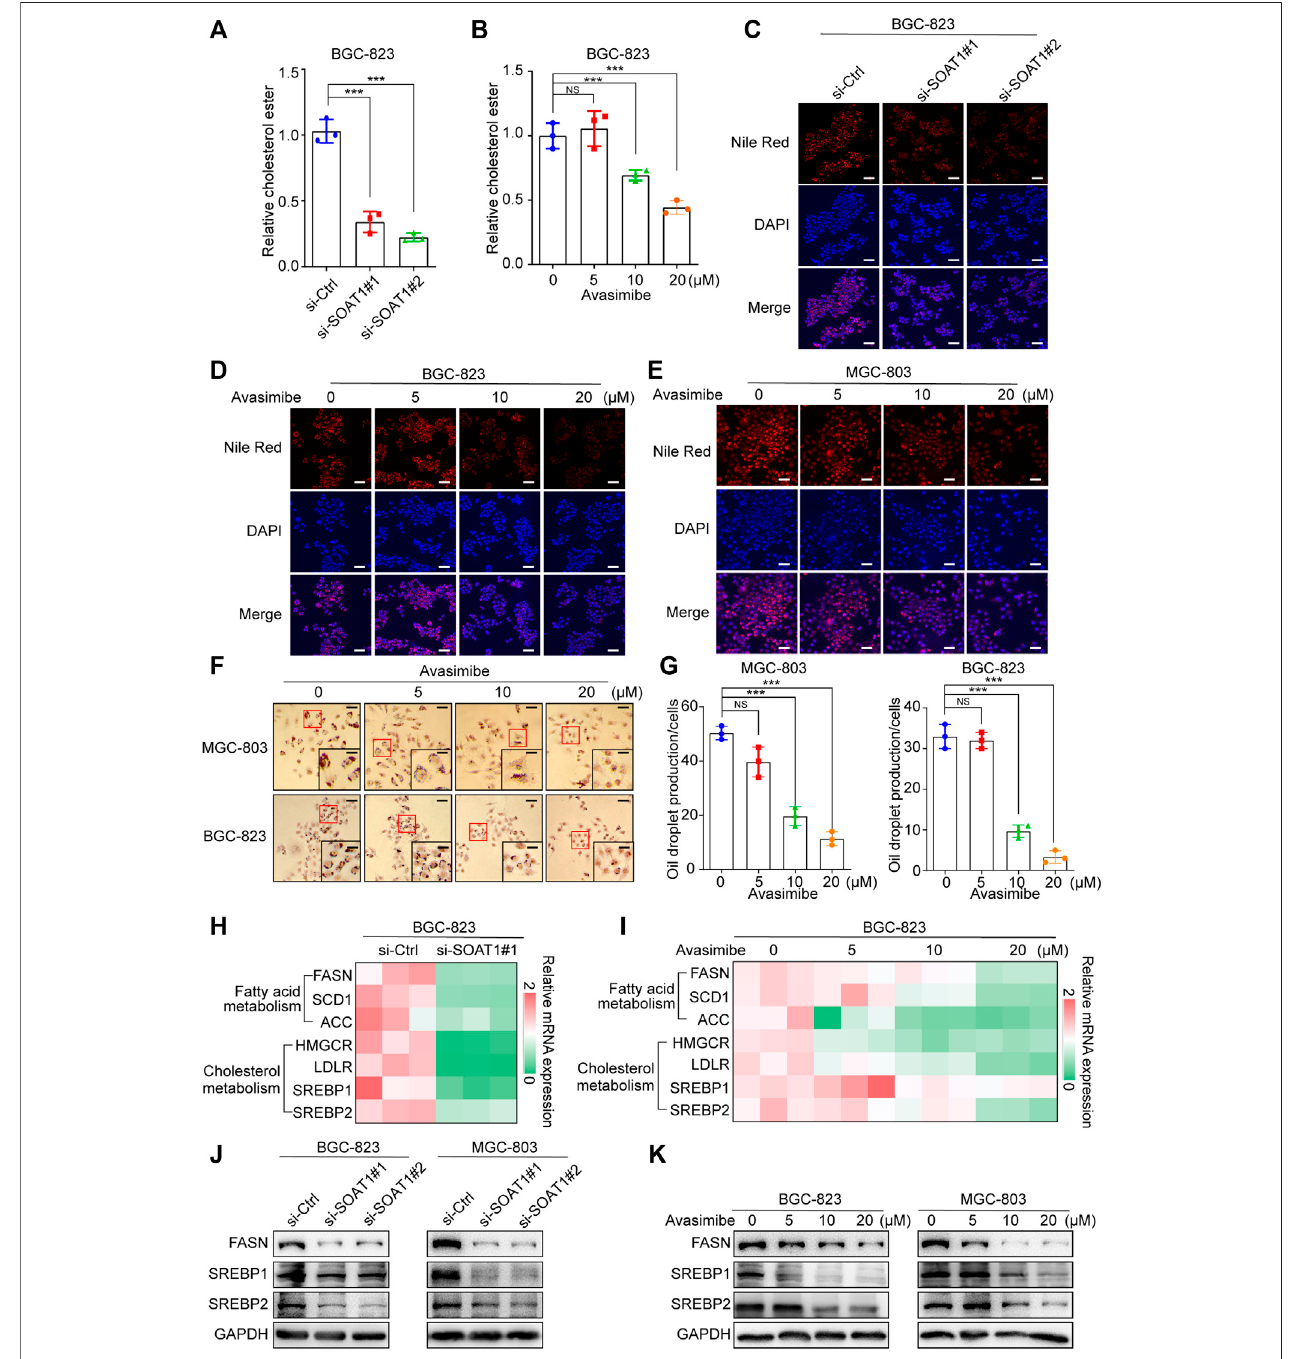
FIGURE5| InhibitionofSOAT1decreasestheleveloflipidsynthesisinGCcells. (A,B) CholesterolesterassaysforBGC-823cellsafterknockdownofSOAT1 (A) or avasimibe treatment (B) . (C) Representative images ofNile red stanning assay in BGC-823 cells after knockdown ofSOAT1. Scale bars: 100 µm. (D, E) Representative imagesofNileredstanningassayinBGC-823 (D) and MGC-803 (E) cellsafter avasimibe treatment.Scalebars:100 µm. (F) RepresentativeimagesofOilredOstaining in BGC-823 and MGC-803 cells after avasimibe treatment. (G) Quantitative data for lipid synthesis were shown. Scale bars: 100 and 50 μ m, respectively. (H,I) HeatmapgeneratedfromtheqRT-PCRresultsshowedthegeneexpressionlevelsofcholesterolmetabolism andfattyacidbiosynthesis-relatedgenesinBGC-823cells after knockdown of SOAT1 (H) or avasimibe treatment (I) . (J,K) FASN, SREBP1, and SREBP2 protein expression were measured by western blot assay after knockdown of SOAT1 (J) or avasimibe treatment (K)